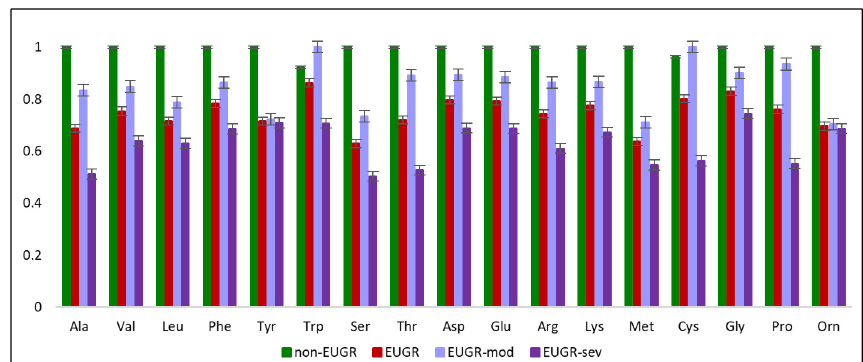
Figure 3. The scaled relative abundance of statistically significant amino acids reflecting the differences between non ‐ EUGR and EUGR, together with stratification for moderate and severe EUGR cases.